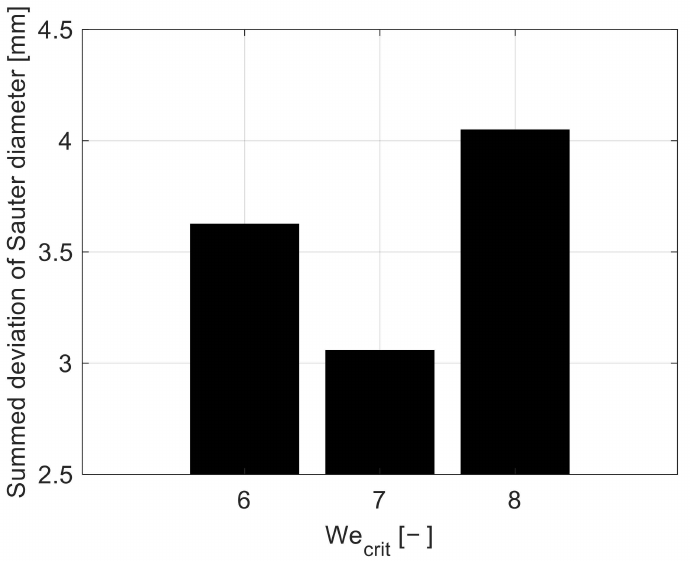
Figure 7. The summed deviation of the Sauter mean bubble diameter for different critical We numbers of the fitted model for Luo et al.